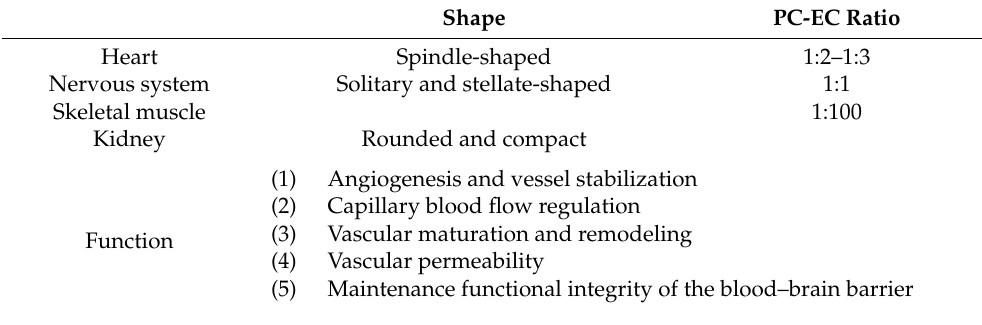
Table 2. Diverse shape and endothelial cell (EC) coverage ratio of pericytes and their function. Shape PC-EC Ratio Heart